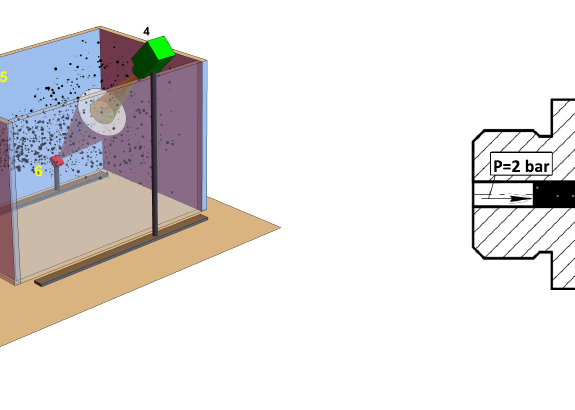
Figure 1. Scheme of experimental setup ( a ) and the cross-section of the nozzle ( b ). There are the compressor (1), fuel reservoir (2), nozzle (3), high-speed video camera (4), volume for the fuel airspraying (5), light source (6). The pressurized shot of fuel is shown in the middle of ( b ) by